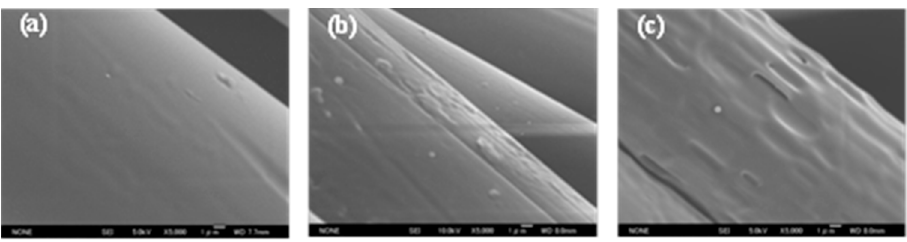
Figure 8. SEM images of hydrolyzed PLA fibers: ( a ) original PLA fiber; ( b ) P-3 and ( c ) P-4. The fibers were immersed in PBS (1M, pH 7.2) at 37 °C for 6